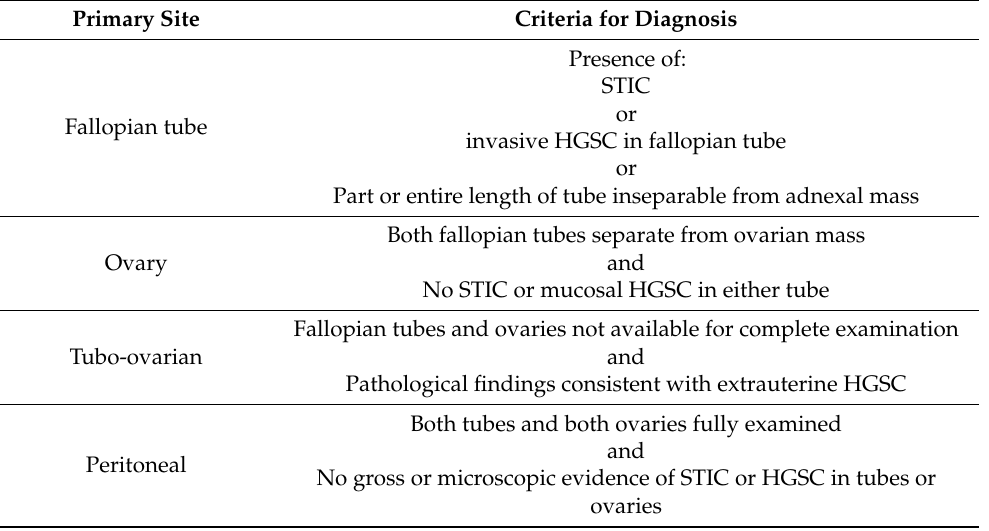
Table 2. Criteria for assigning primary site in high-grade serous